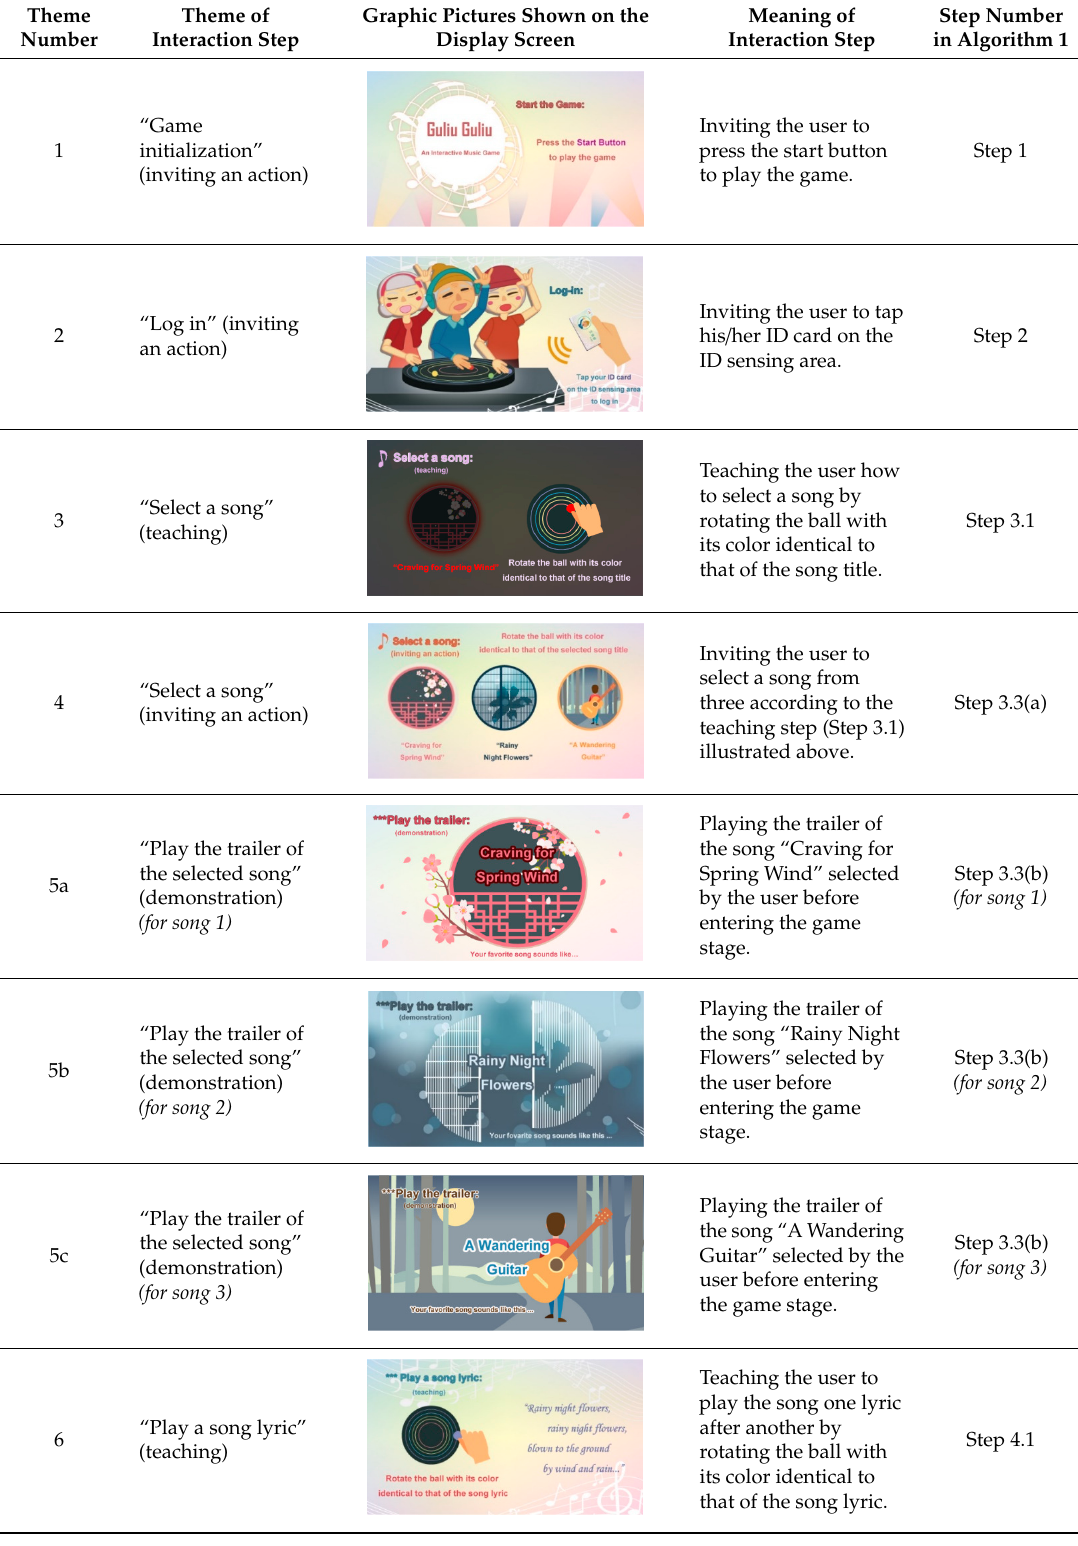
Table 3. List of intermediate interaction results yielded by the “Guliu Guliu” game described by Algorithm 1.